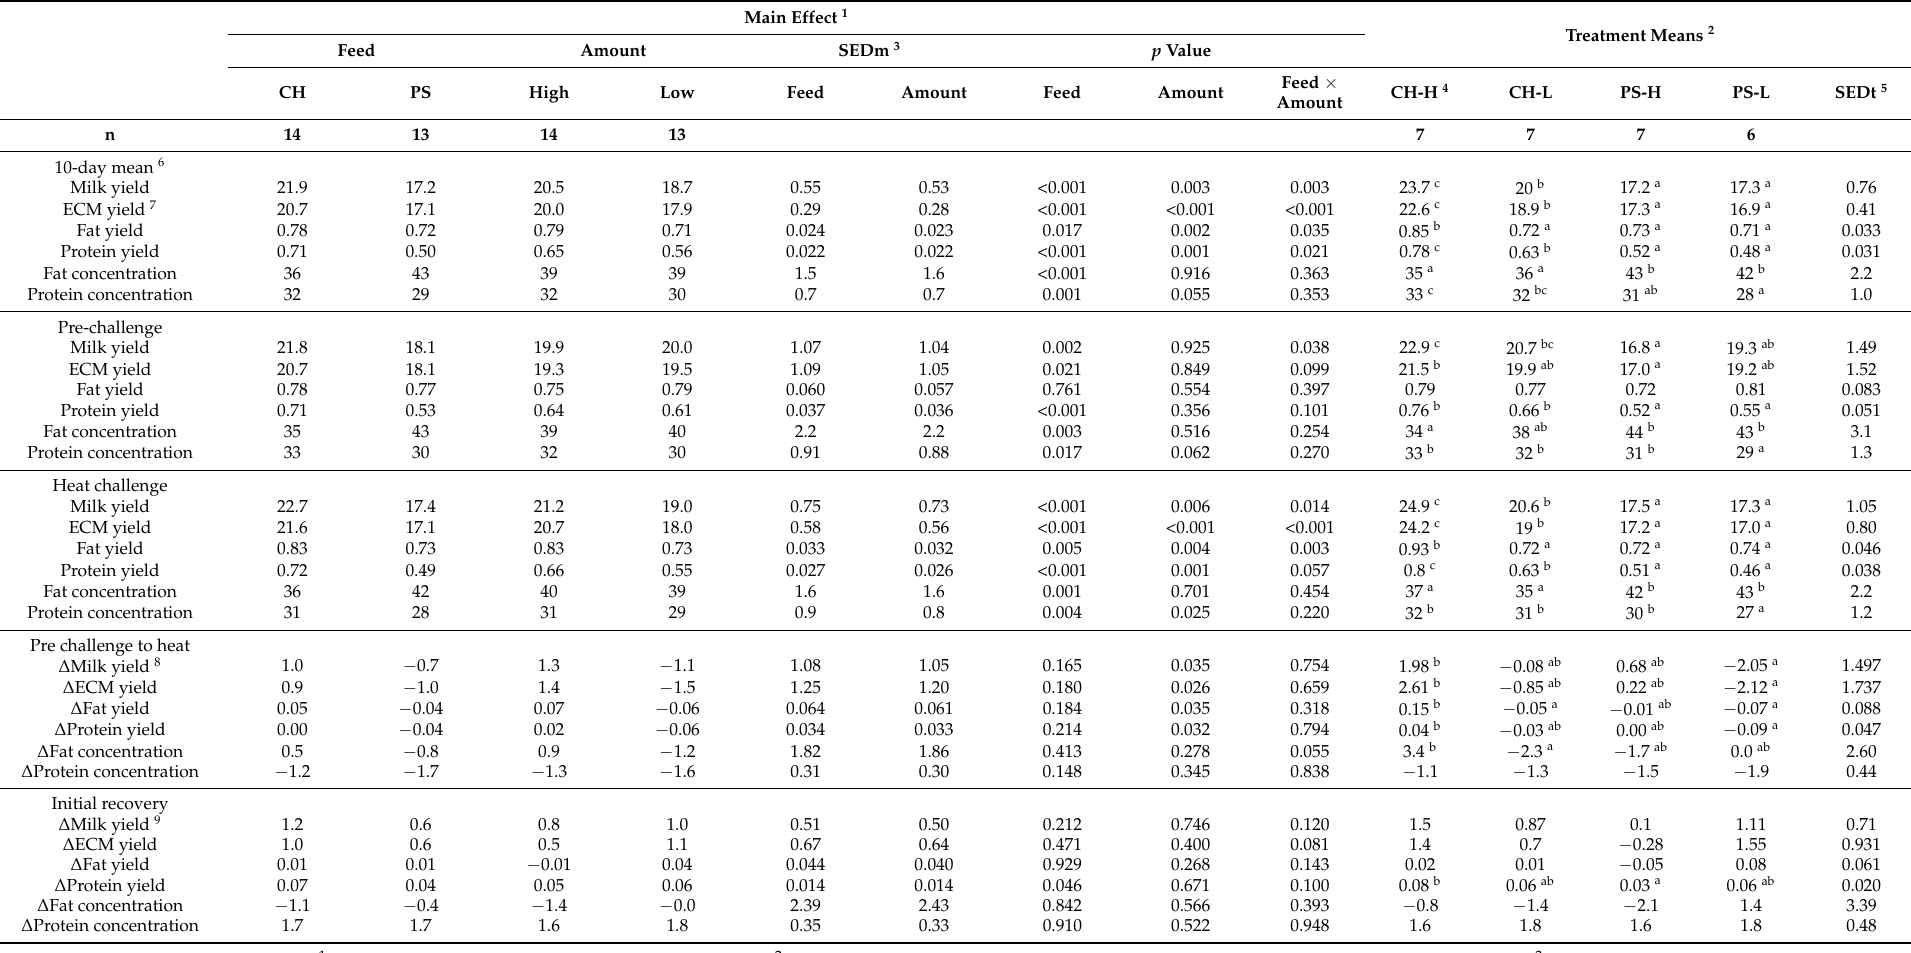
Table 6. Milk yield and yield of milk components (kg/d) and milk composition (g/kg) across the 10 days of measurement and during selected periods of the